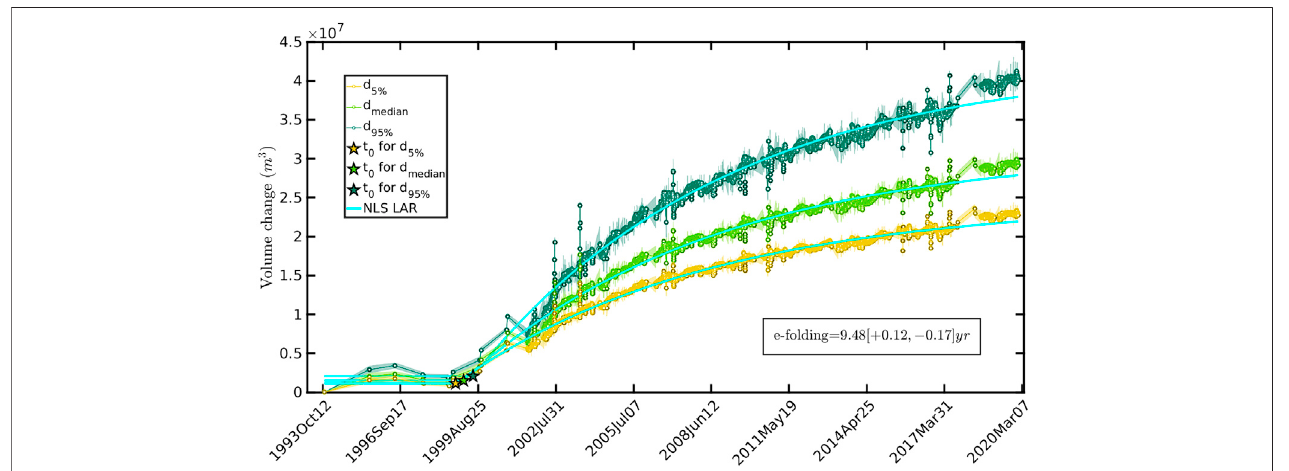
FIGURE 10 | Volume change time series for a Mogi source (constrained by both the GPS and InSAR data), at different depth estimations ( Table 1 ): median value (light green), 95 and 5% percentile values (yellow and dark green). Cian solid lines represent predicted curves through Non Linear Least Squares (NLS), Least Absolute Residuals (LAR) method, following the e-folding characteristic shape function of Eq. 8 . Stars show the location of the beginning of the exponential function: for data associated with median depth value estimation (light green), 95 and 5% percentile values (yellow and dark green).